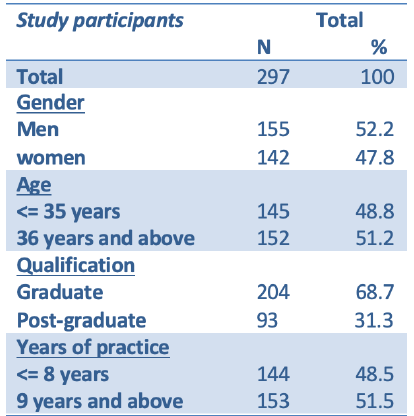
Table 1. Baseline characterisDcs of parDcipat- ing